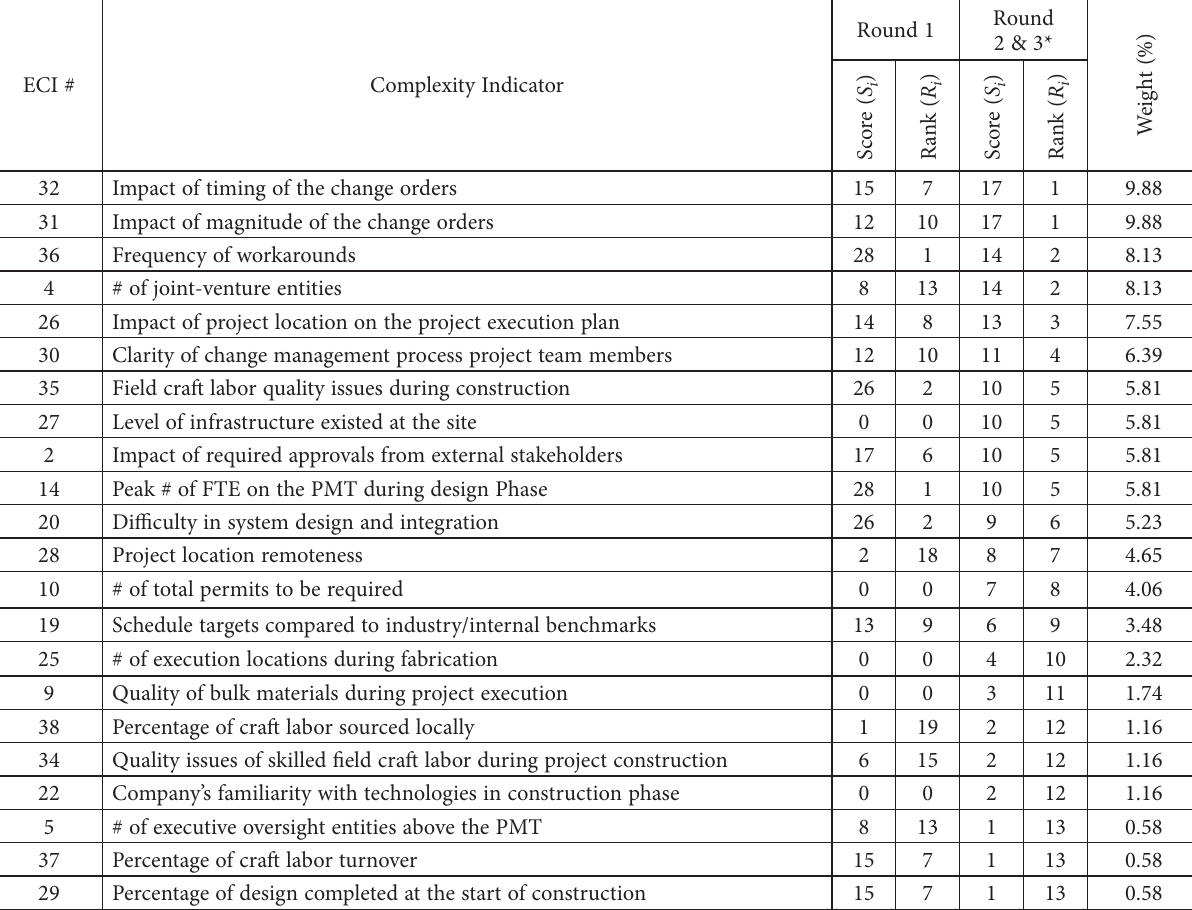
Table 3. Identified complexity indicators corresponding to contractor’s perspective, ranking, and weighting of them